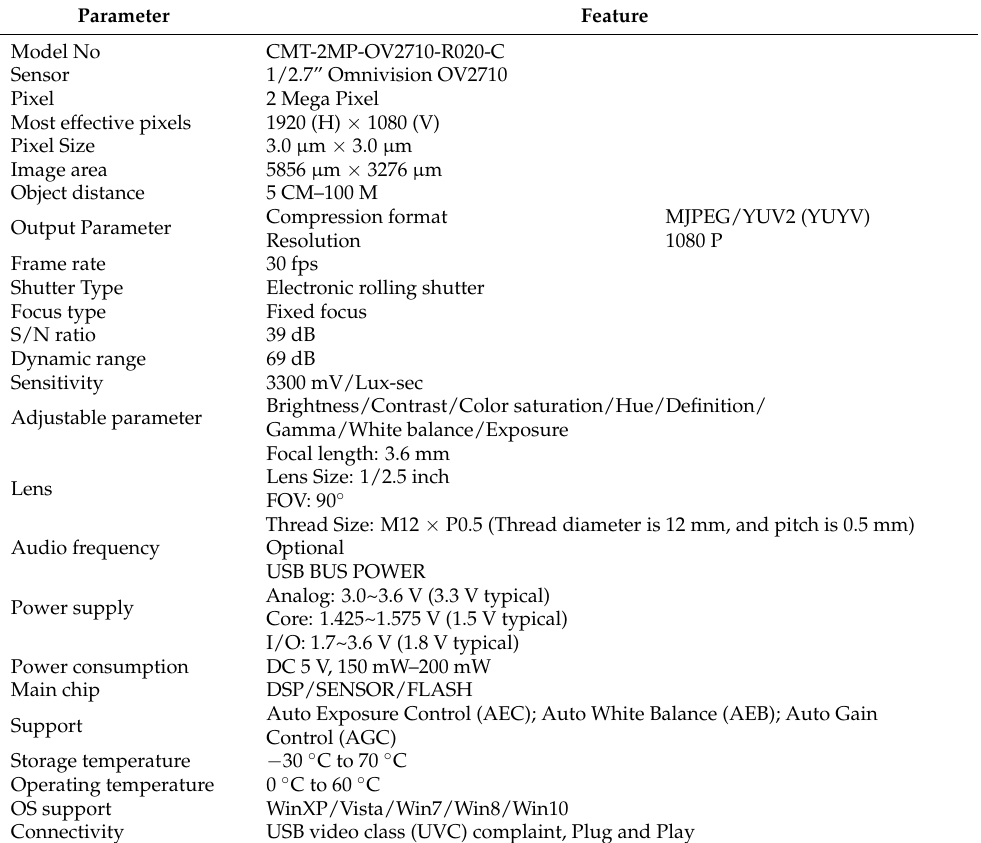
Table 4 encapsulates the digital camera parameters of the considered AI camera in the proposed IMS. Table 4. Parameters of AI camera (Omnivision OV2710 CMOS) used in the proposed